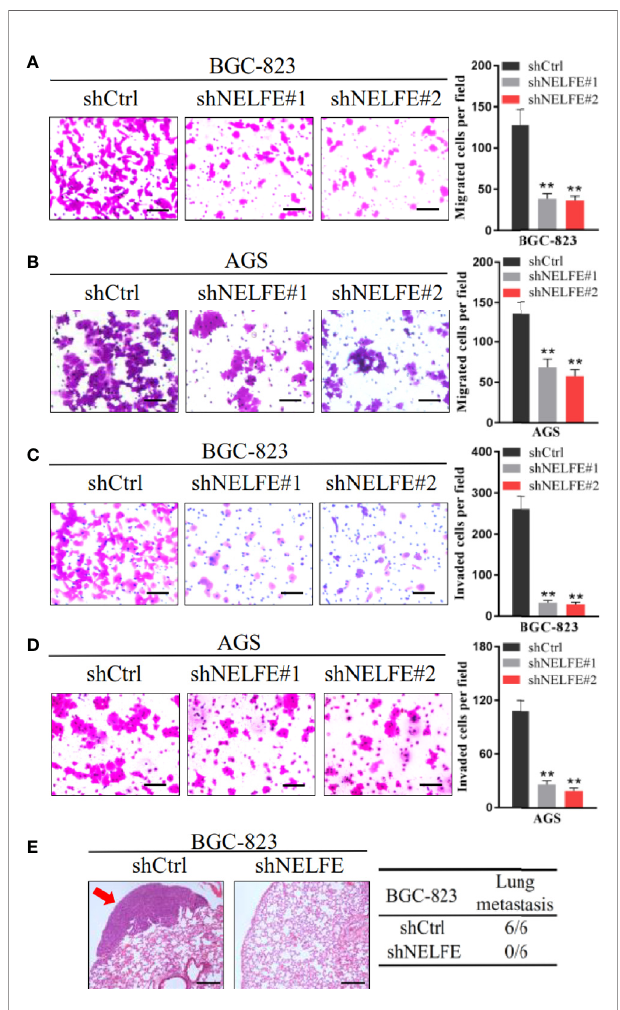
FIGURE 3 | NELFE promoted metastasis of human gastric cancer cells. (A, B) Transwell migration and (C, D) Invasion assays. (E) , Five-week-old male nude mice were used in xenograft assays, and BGC-823 cells were injected into the tail vein. Representative images of H&E staining of lungs and incidence of lung metastasis from mice inoculated with BGC-823 cells. **P <